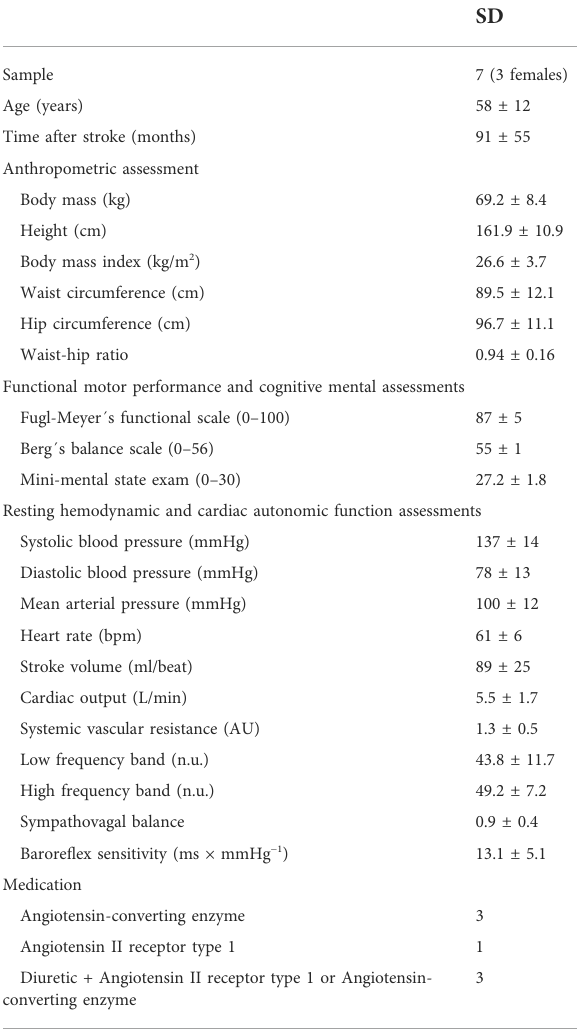
TABLE 1 Characteristics of the study